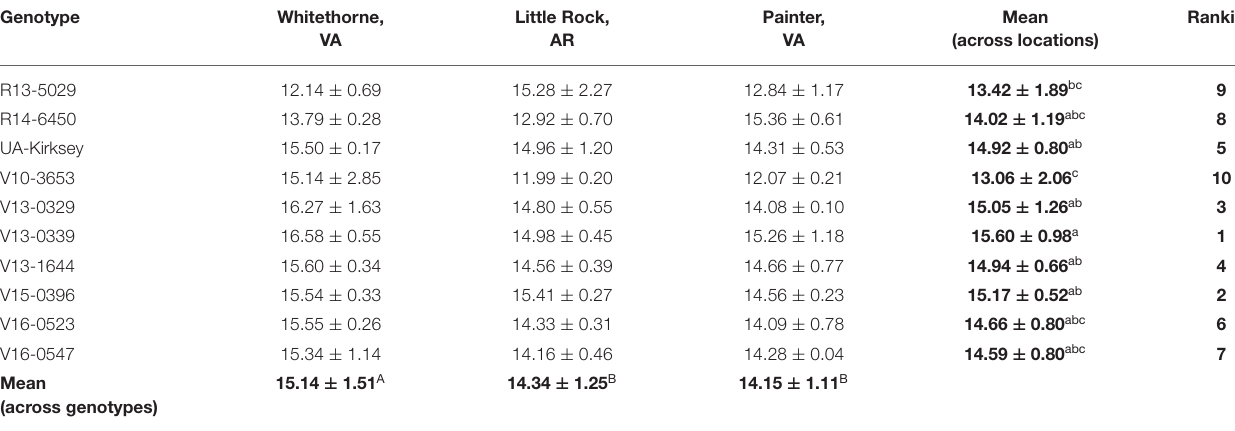
TABLE 8 | Starch contents (%, d.b.) of 10 edamame genotypes planted in different locations.